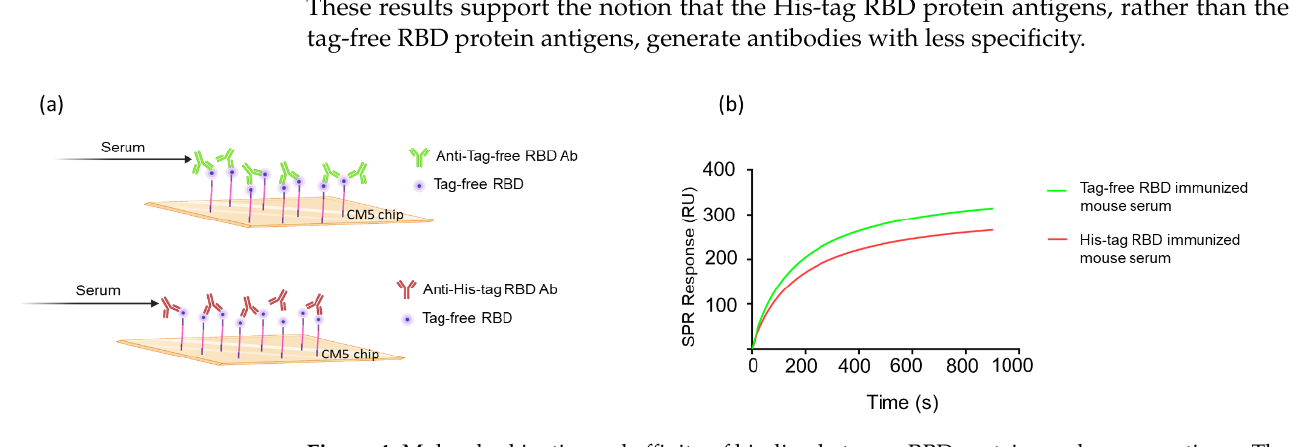
Figure 4. Molecular kinetics and affinity of binding between RBD proteins and mouse antisera. The CM5 chip was immobilized with tag-free RBD proteins, and the mouse antisera were derived from tag-free RBD antigens or His-tag RBD antigens ( a ). The SPR binding curve was modeled using Prism 9.0 ( b ).